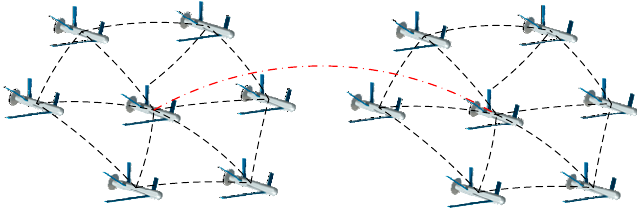
Figure 2. Schematic of typical Structure 2.